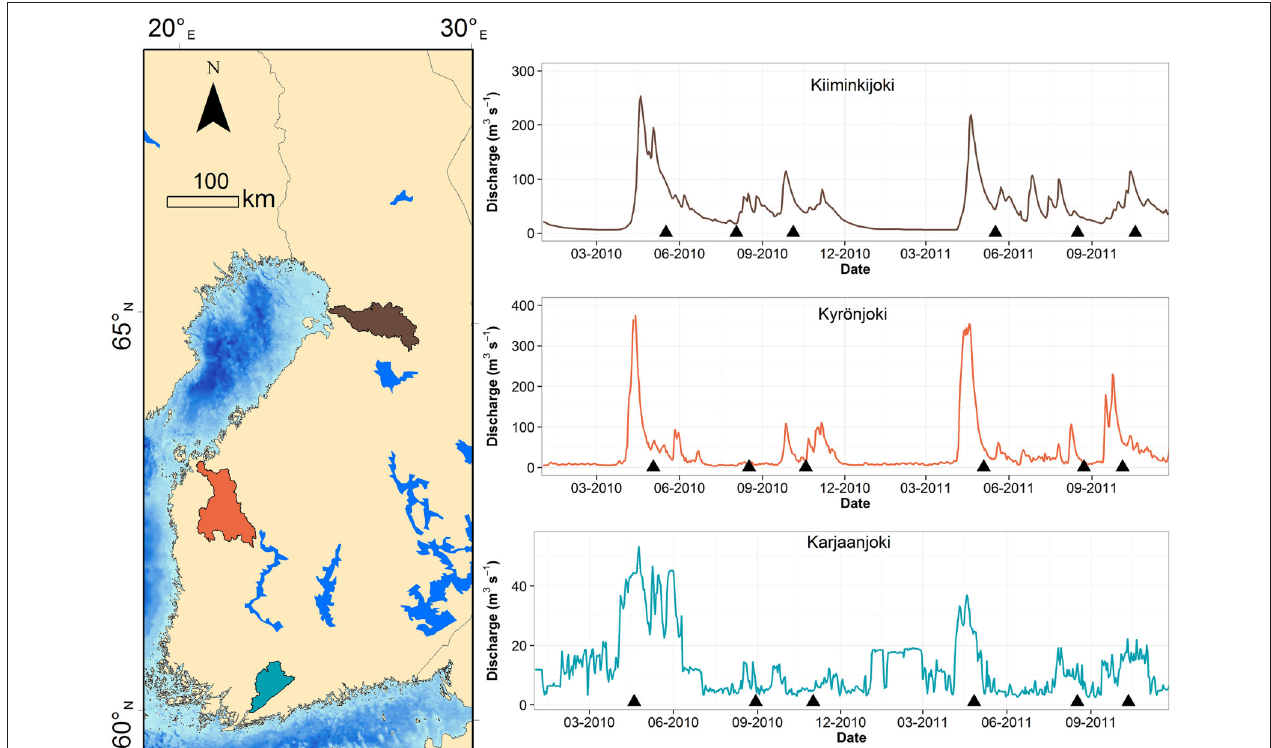
FIGURE 1 | Map of study estuaries and river discharges during the study period. Sampling occasions are marked with a triangle symbol. Catchment of each river is colored with respective color as in discharge graph.